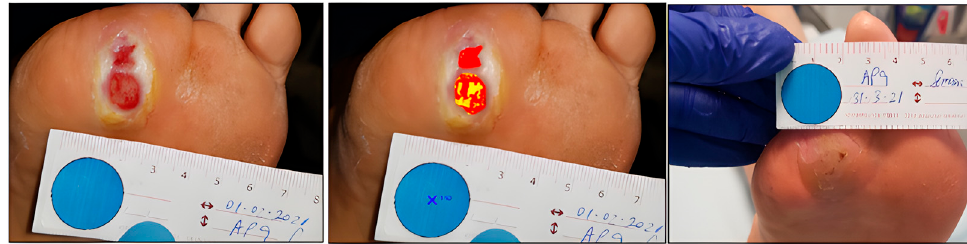
Figure 9. Healing evolution case 5: Baseline assessment ( left ), Baseline HELCOS analysis ( centre ), Week 8 assessment ( right ).